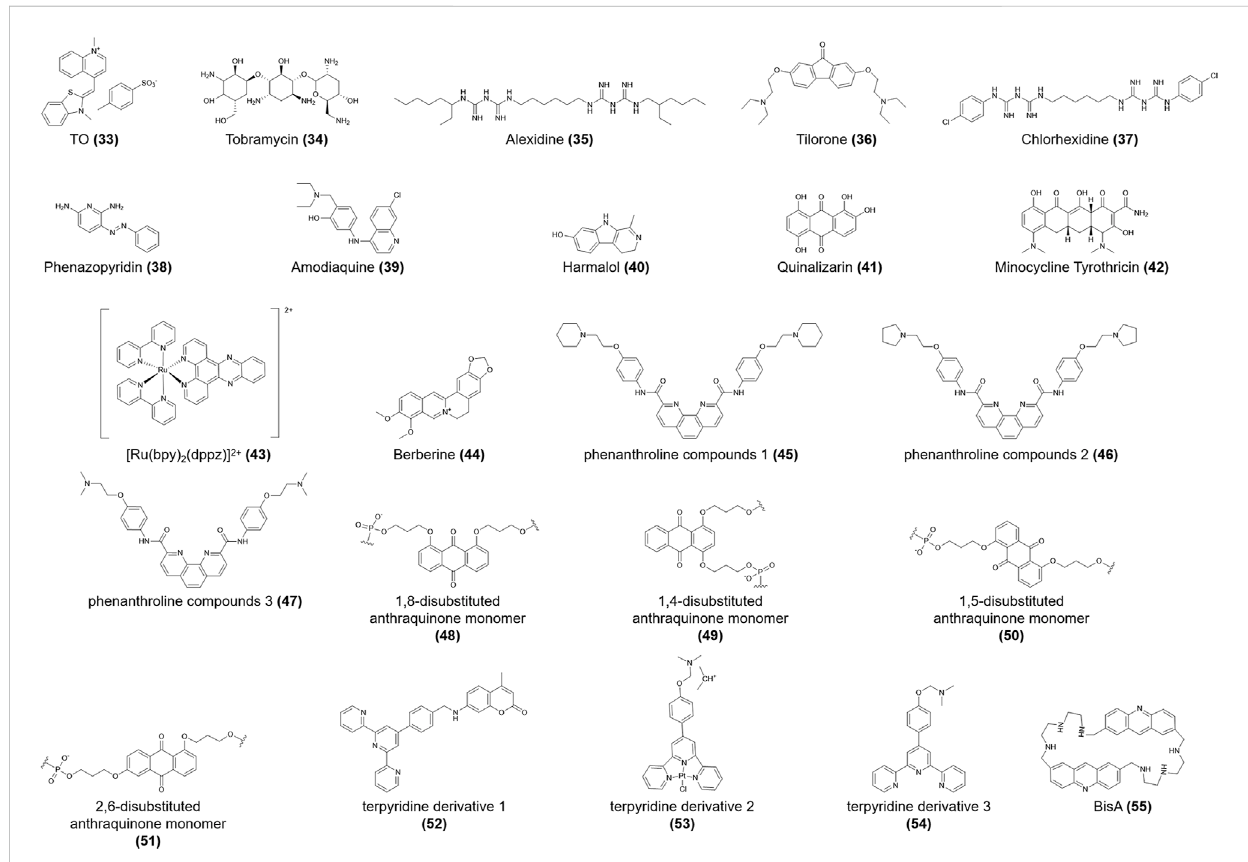
FIGURE 6 Structures of compounds ( 33 – 55